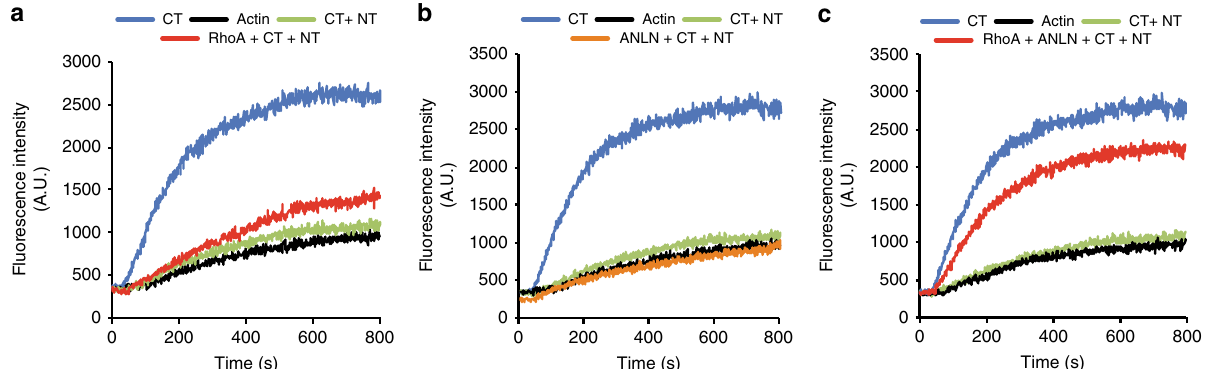
Fig. 2 Anillin (ANLN) enhances RhoA-mediated activation of DIAPH3 actin nucleation activity. Pyrene-labeled actin polymerization assays comparing the relative actin polymerization activity of GST-DIAPH3-CT and a complex of GST-DIAPH3-CT + MBP-DIAPH3-NT in the presence of a GST-RhoA, b 6× His-anillin (1 – 151) , and c GST-RhoA and 6× His-anillin (1 – 151)